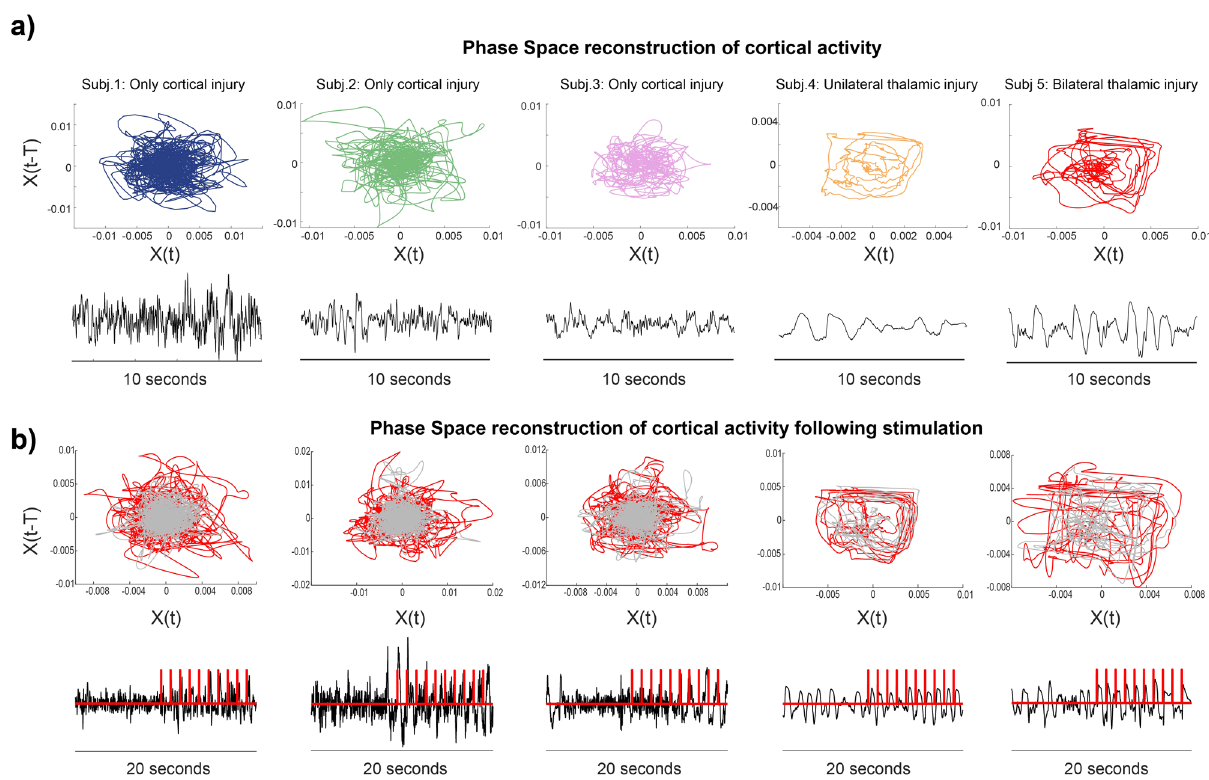
Fig. 3 Reconstructed phase space of depth cortical recordings reveals a low dimensional attractor for patients with thalamic injury. a We reconstructed the phase space of recordings obtained from depth PFC recording for all the patients. Patients 4 and 5 with unilateral and bilateral thalamic injury, respectively, show a structured phase space that repeatedly visits similar trajectories re fl ecting a limited number of available states in the repertoire of cortical networks. b Phase space of 20 s of cortical recordings consisted of a ten-second baseline (gray) followed by a ten-second train of single pulses of stimulation (red). The timing of single pulses is shown in red on the recorded LFP. Responses are consistent with a ring attractor in patients 4 and